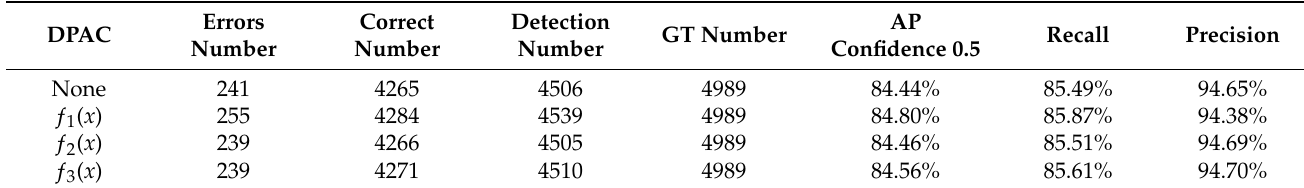
Table 5. Experimental confidence results are 0.5, and DPAC function is different.